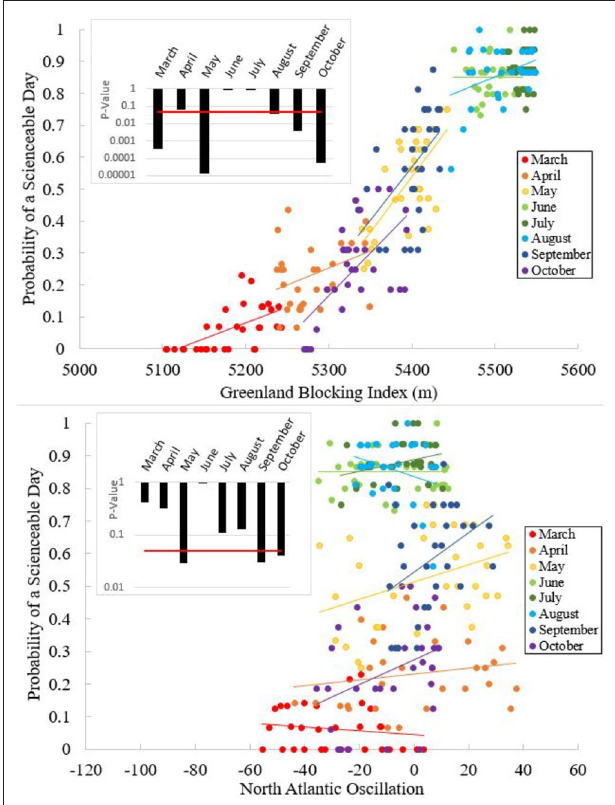
FIGURE 6 | Relationship between scienceability and GBI (top) and NAO (bottom) for each month of the year at DYE-2. Circles represent data between 1996 to 2016 with each month separated by color. Solid lines show linear regression for each month (same color scale as data points). The inset figures show the p -values of the linear relationships in the associated panels of the figure. The red line in each inset figure indicates a p -value of 0.05.